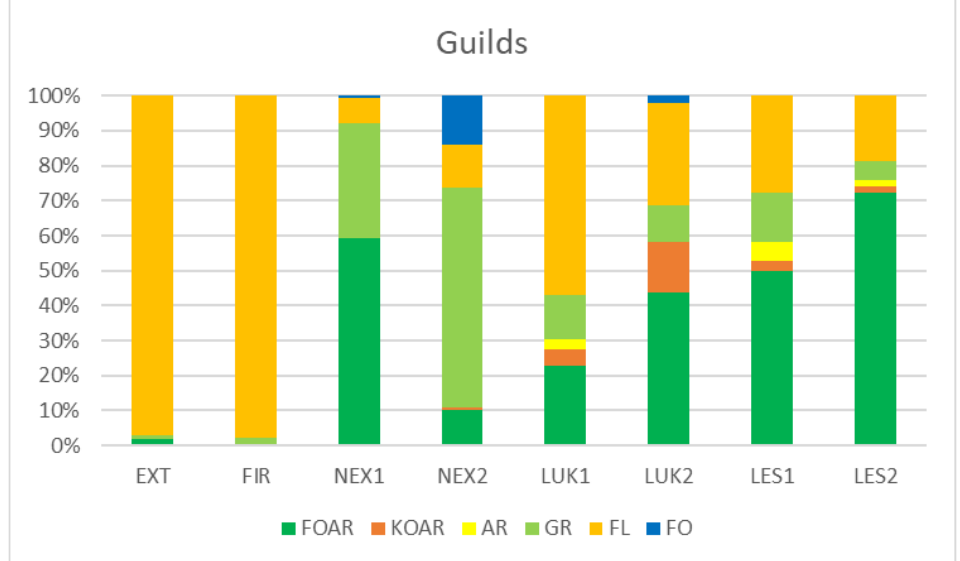
Figure 5. Percentage representation of species abundance belonging to the guilds at the studied plots. FOAR—foliicolous arboricolous species, KOAR—corticicolous species, AR—arboricolous species, GR—graminicolous species, FL—floricolous species, FO—Foliicolous species.